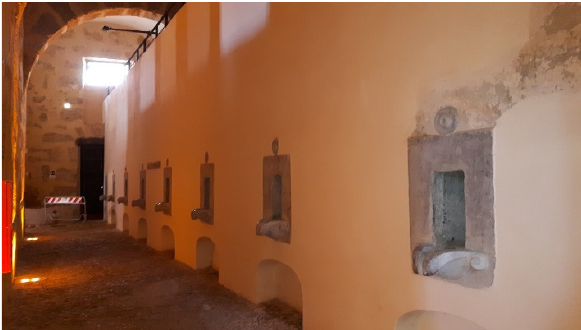
Figure 3 . Interior of the “ Real Cantina Borbonica ”: the left aisle with the wine vats.